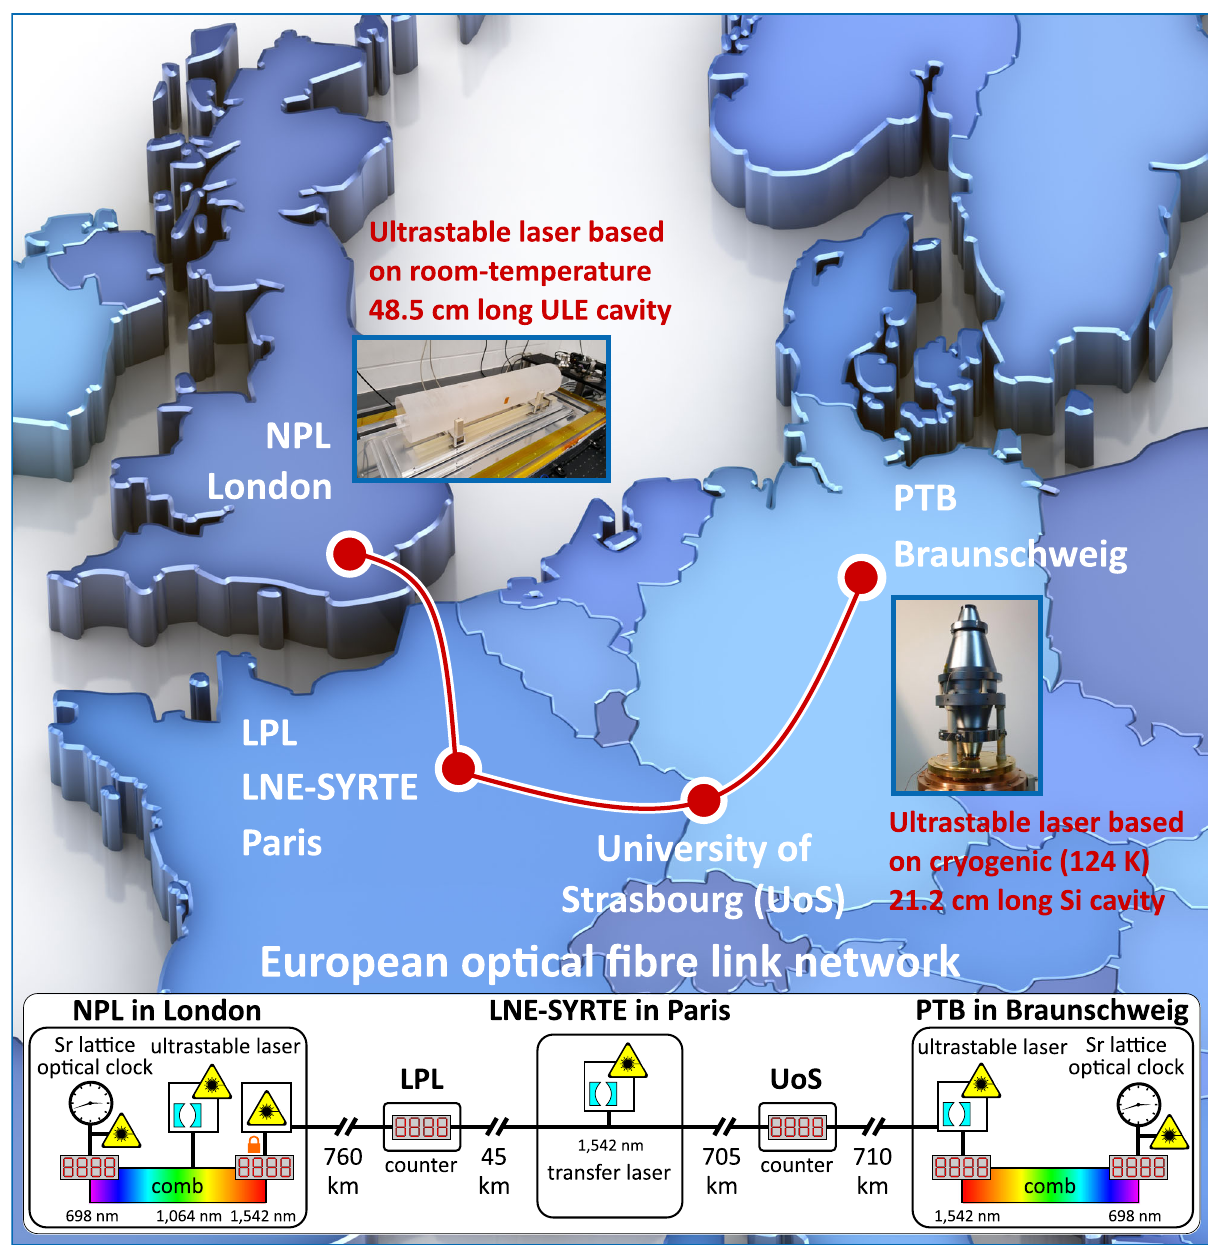
Fig. 1 Ultrastable laser and optical fi bre link network experiment layout. Schematic of the 2220 km long optical fi bre link connecting NPL in London (UK), LPL and LNE-SYRTE in Paris (France), University of Strasbourg UoS (France) and PTB in Braunschweig (Germany). The link enables distant state-of-the-art ultrastable lasers at NPL and PTB to be compared. The NPL laser at 1064 nm is based on a room-temperature 48.5 cm long ultra-low-expansion (ULE) optical cavity and its stability is transferred via an optical frequency comb to a laser at 1542 nm. The PTB laser at 1542 nm is based on a 21.2 cm long silicon cavity at 124 K. The Sr optical lattice clocks at NPL and PTB are used to verify the stability performance of the ultrastable lasers. The picture of the PTB silicon cavity is taken from ref. 58